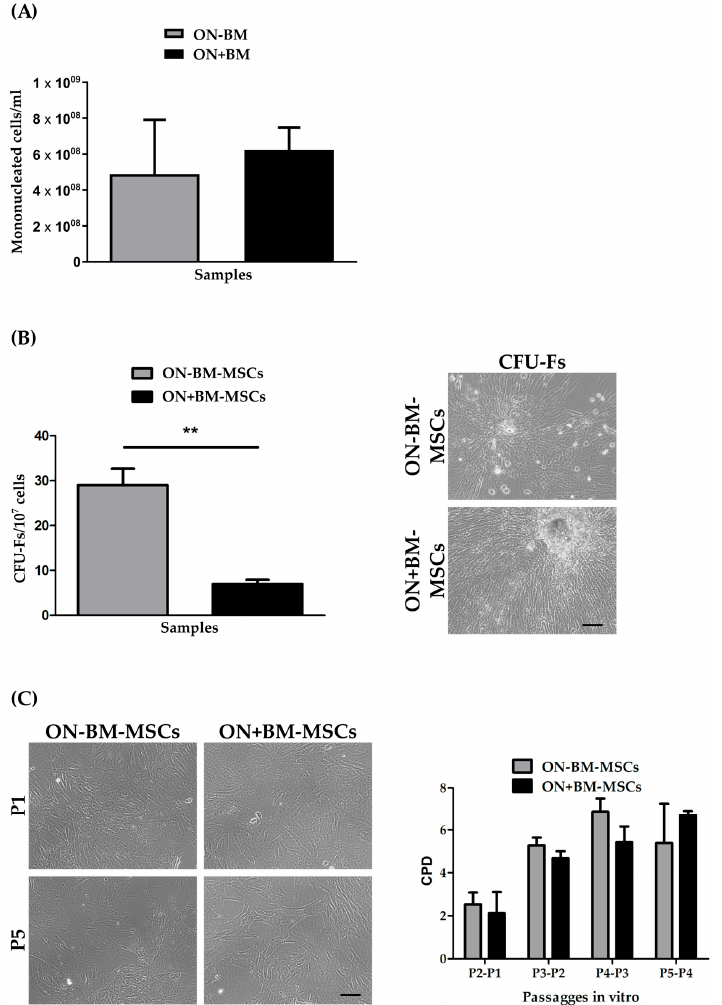
Figure 4. Mesenchymal stromal/stem cell (MSC) isolation from bone marrow (BM). ( A ) Mononucleated cells per ml of BM from rabbit femoral head before and after osteonecrosis (ON) damage. ( B ) The fibroblastic colony-forming units (CFU-Fs) per 10 7 cells were counted 9 days after seeding for MSCs isolated from BM before (ON-BM-MSCs) and after (ON+BM-MSCs) ON event (** p < 0.01; 10× magnification; scale bar 100 µm). ( C ) Cell morphology of ON-BM-MSCs and ON+BM-MSCs (left panel, 10× magnification; scale bar 100 µm) and their cumulative population doubling (CPD) until passage 5.